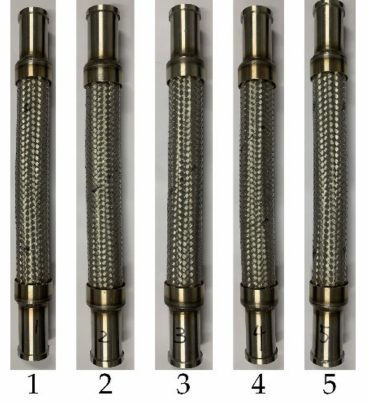
Figure 15. The test